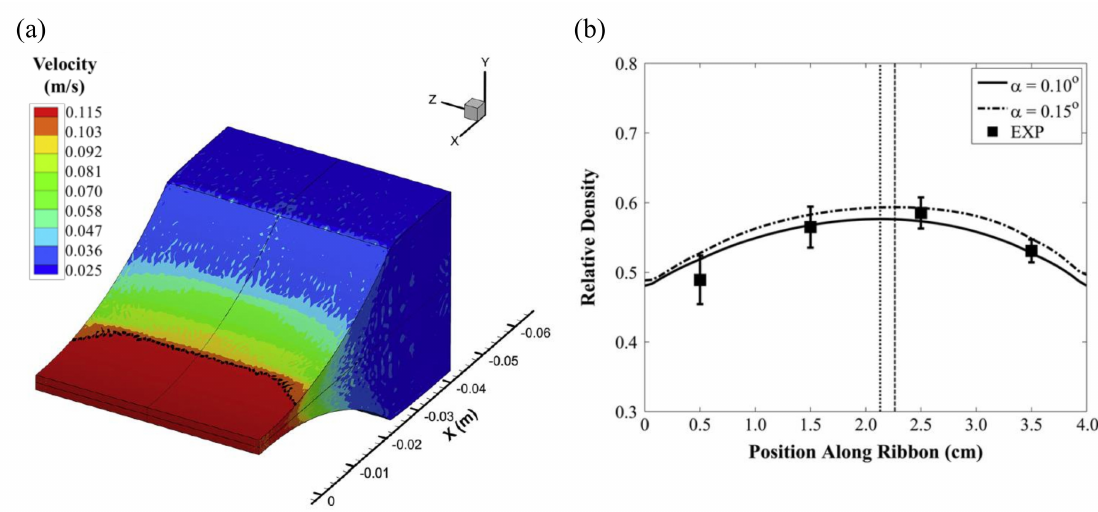
Figure 19. Predicted result by FEM simulation [166]: ( a ) powder velocity distribution at 0.12 m / s roll; ( b ) ribbon density distributions using inlet stress and roll gap were 164 kPa and 2.32 mm. α is roll tilt. The figures were slightly modified, with permission from Elsevier.